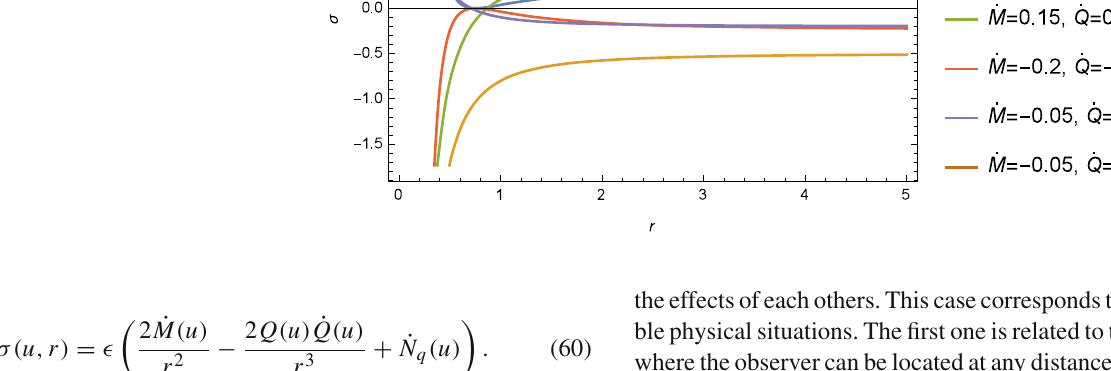
Fig. 10 Radiation-accretion density σ versus the distance r for some typical constant ˙ M , ˙ Q and ˙ N q values for (cid:2) = − 1 in the dust background. Here, we have set Q = 1 for